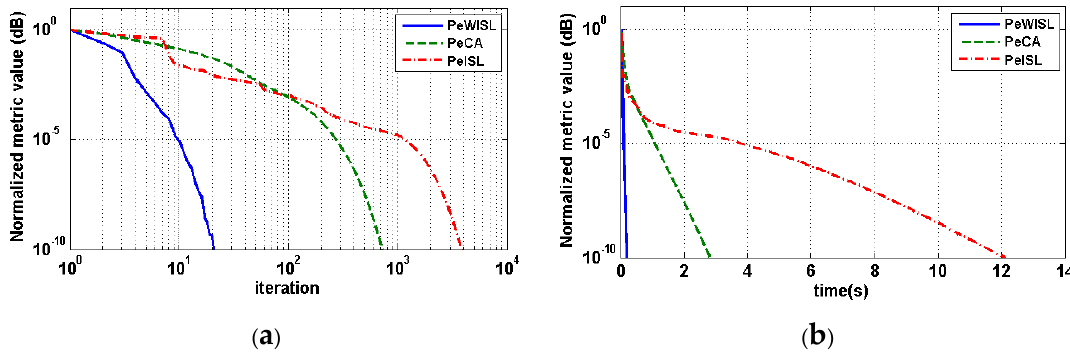
Figure 2. The evolution curves of the metric values with respect to ( a ) iterations and ( b ) consuming time of sequences with length N = 128.